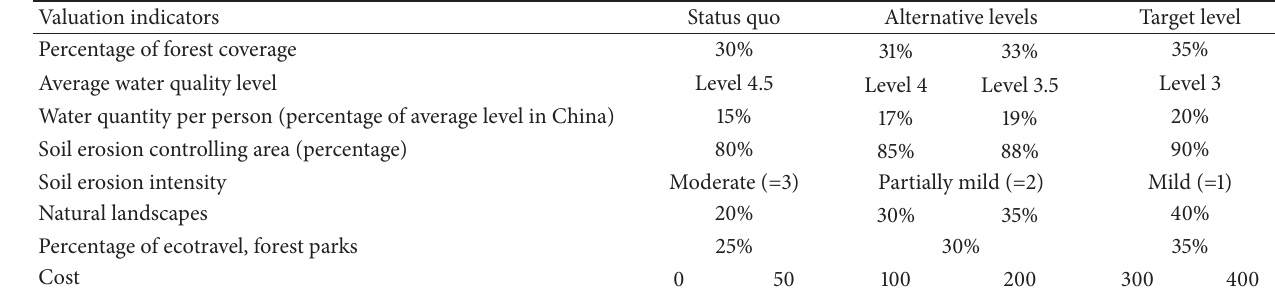
Table 1: Levels of different valuation